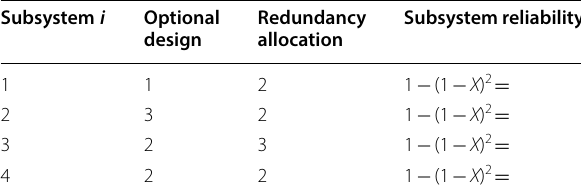
Table 3 Optional design of δ and redundancy allocation Subsystem i Optional design